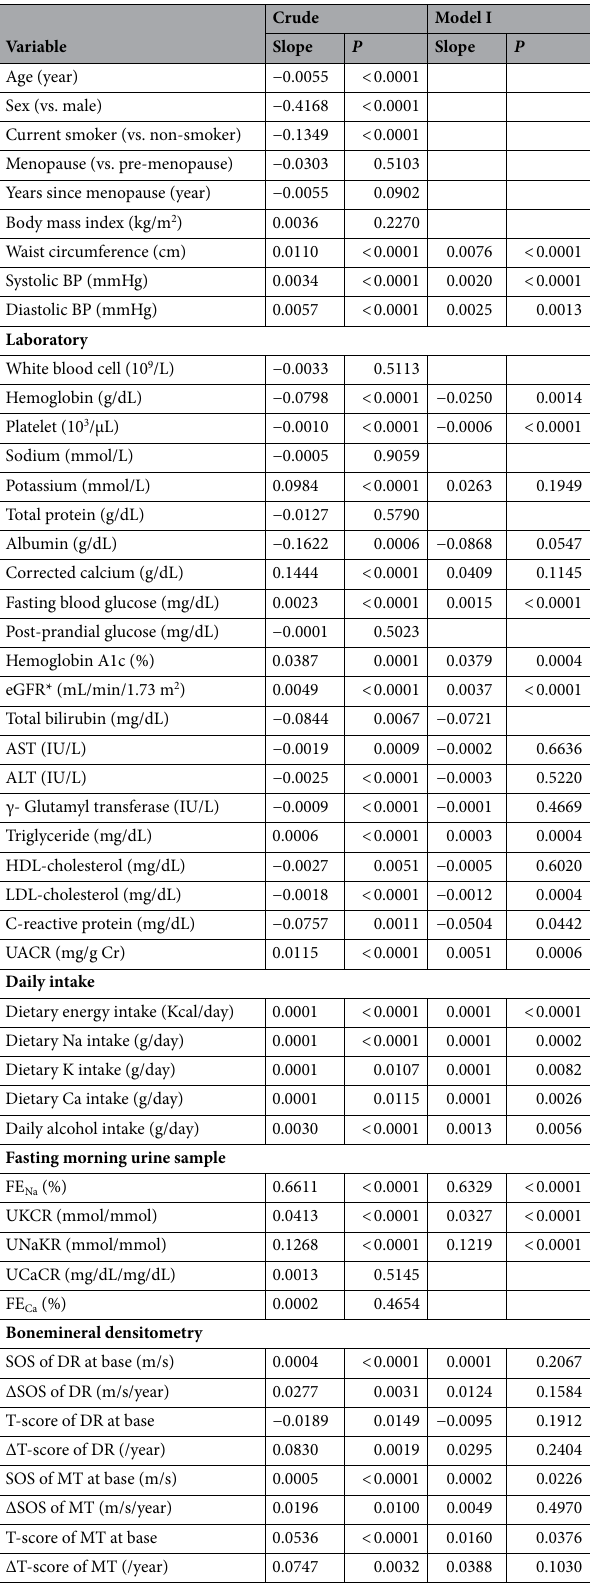
Table 2. Linear regression for e24UNaE Tanaka (g/day). Model I, adjusted for age, sex, and smoking